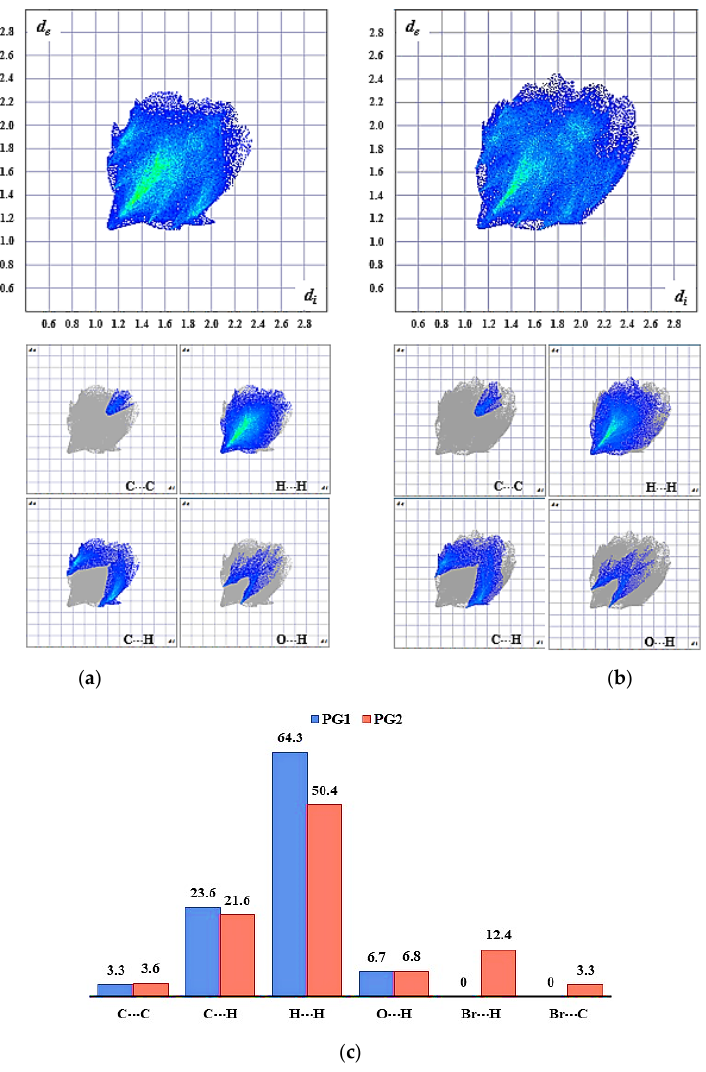
Figure 11. 2D fingerprint plots of the nearest external distance (d_e) versus the nearest internal distance (d_i) for ( a ) BMP and ( b ) BBP chalcones, and the regions corresponding to C···C, C···H, H···H, O···H, Br···H, and Br···C contacts. The colors represent the number of points that share the same d_i, d_e coordinate (light blue: many; dark blue: few). ( c ) Graph of the percentages of each contact on the Hirshfeld surface in the BMP (blue) and BBP (red) chalcones.